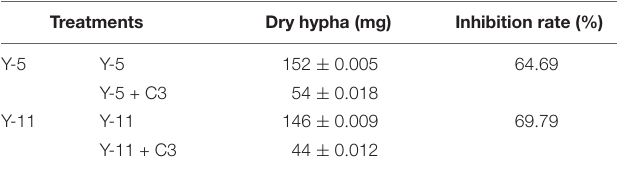
TABLE 1 | Inhibition effect of C3 on Fusarium by liquid